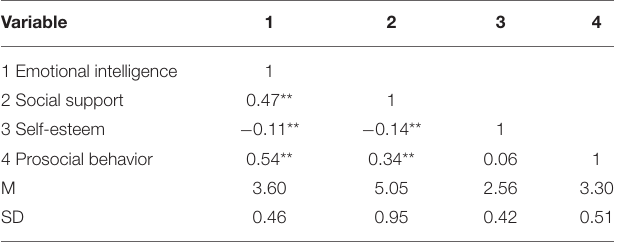
TABLE 1 | Means, standard deviations, and correlations among variables.